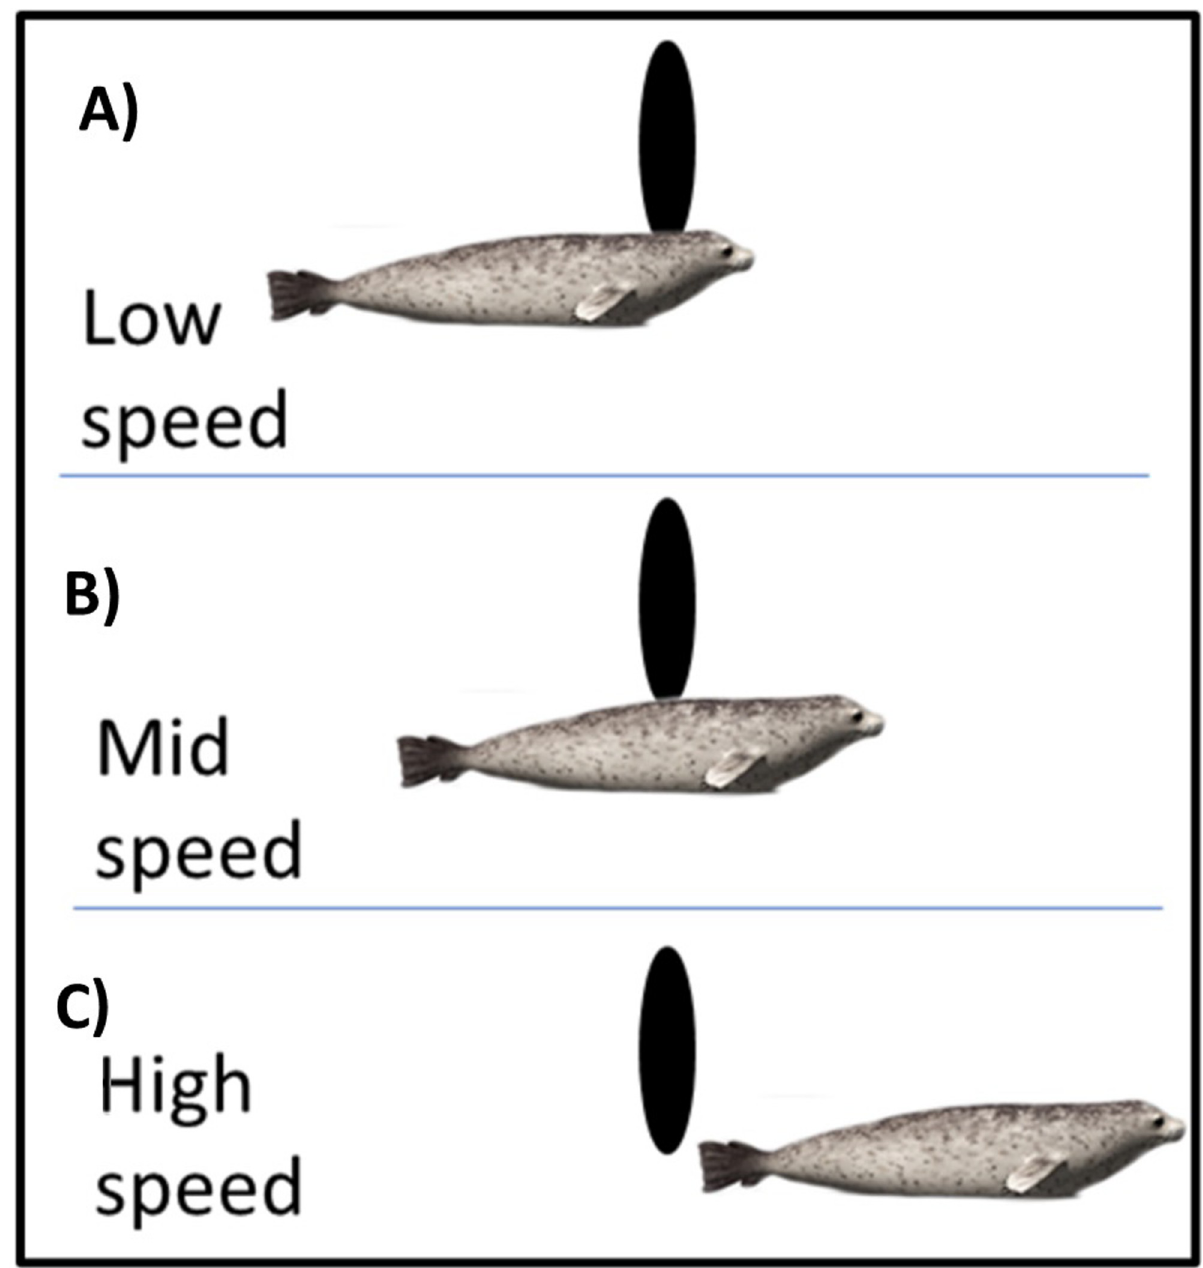
Fig 5. Diagram displaying three potential interactions between a rotating blade (black ellipsoid) and a seal that are likely to occur due to changes in animal approach speed in relation to the speed of the blade. A) Displays a common occurrence with low approach speed, where the animal is moving so slowly that most collisions occur with the head. B) Demonstrates how at mid speed the seal is often moving fast enough for the head to pass the rotating blade before a collision occurs with the torso. C) Represents how at a high speed the seal is often beyond the swept area of the device before the blade